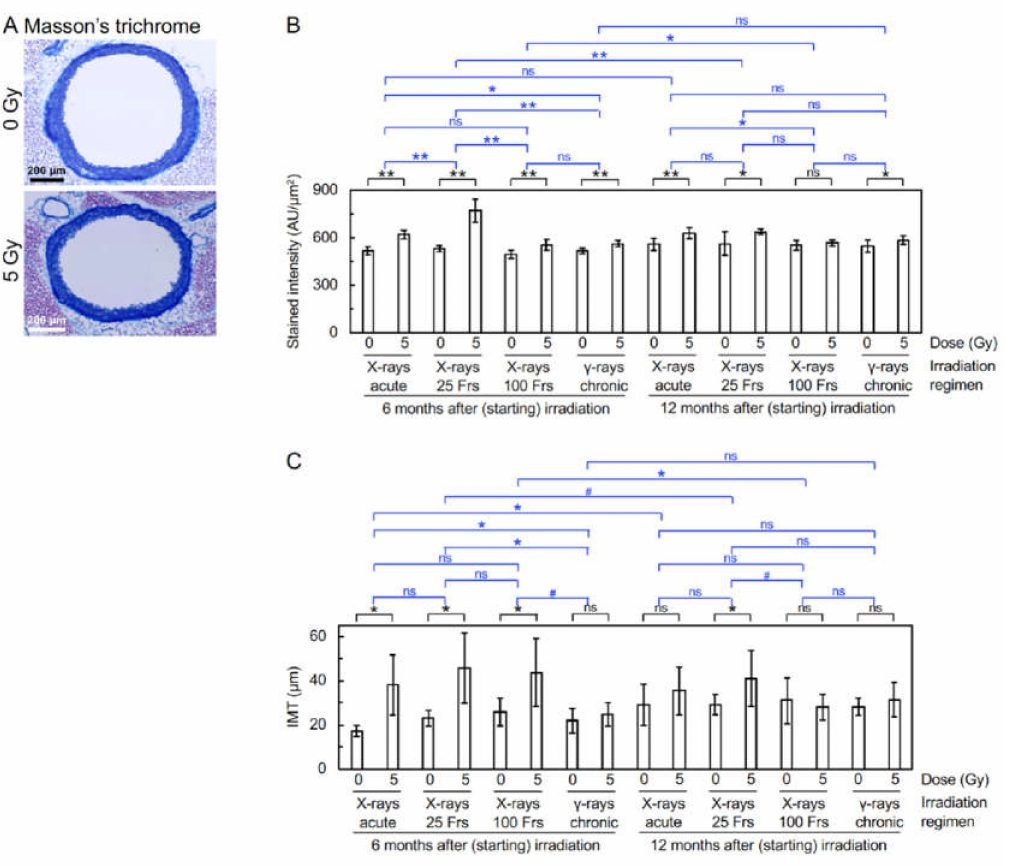
Figure 4. Fibrotic alterations in the aorta. ( A ). Representative images for Masson’s trichrome staining (at 12 mos ASI with 0 Gy or 5 Gy of X-rays in 25 Frs). Scale bars are as indicated. Quantitative analysis for ( B ) intensity of aniline blue (9–10 mice/group analyzed, Welch’s t -test). AU, arbitrary unit. Frs, fractions. **, p < 0.001. *, 0.001 ≤ p < 0.05. #, 0.05 ≤ p < 0.1 (marginally significant). ns, p ≥